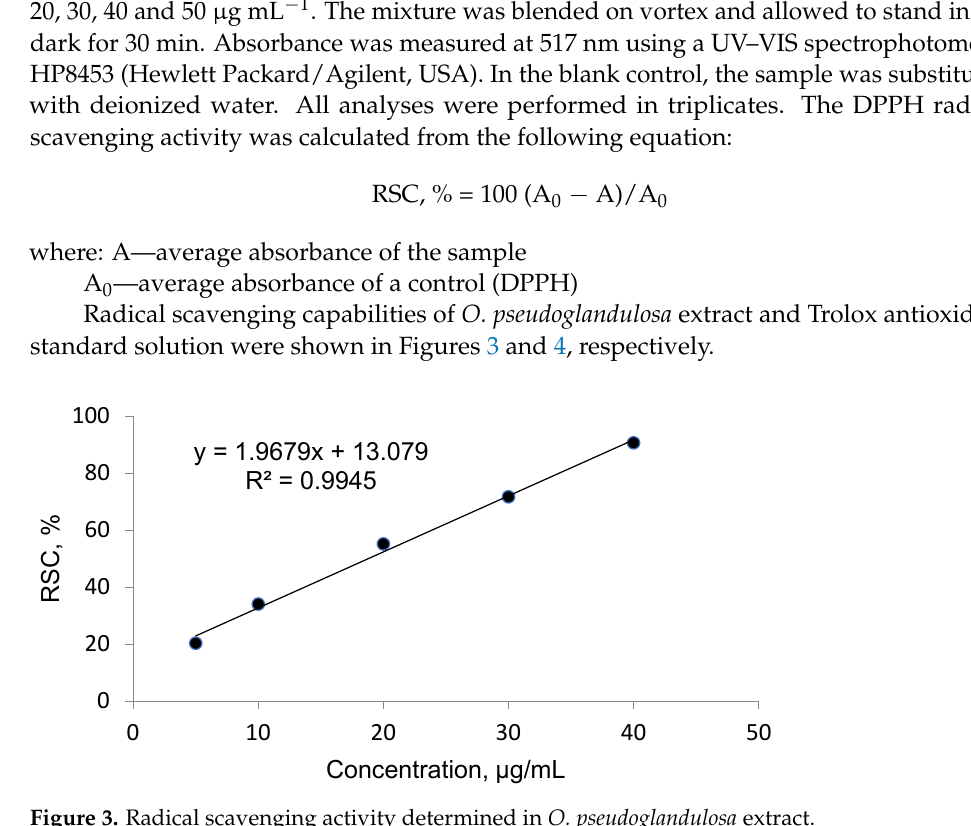
Figure 3. Radical scavenging activity determined in O. pseudoglandulosa extract.